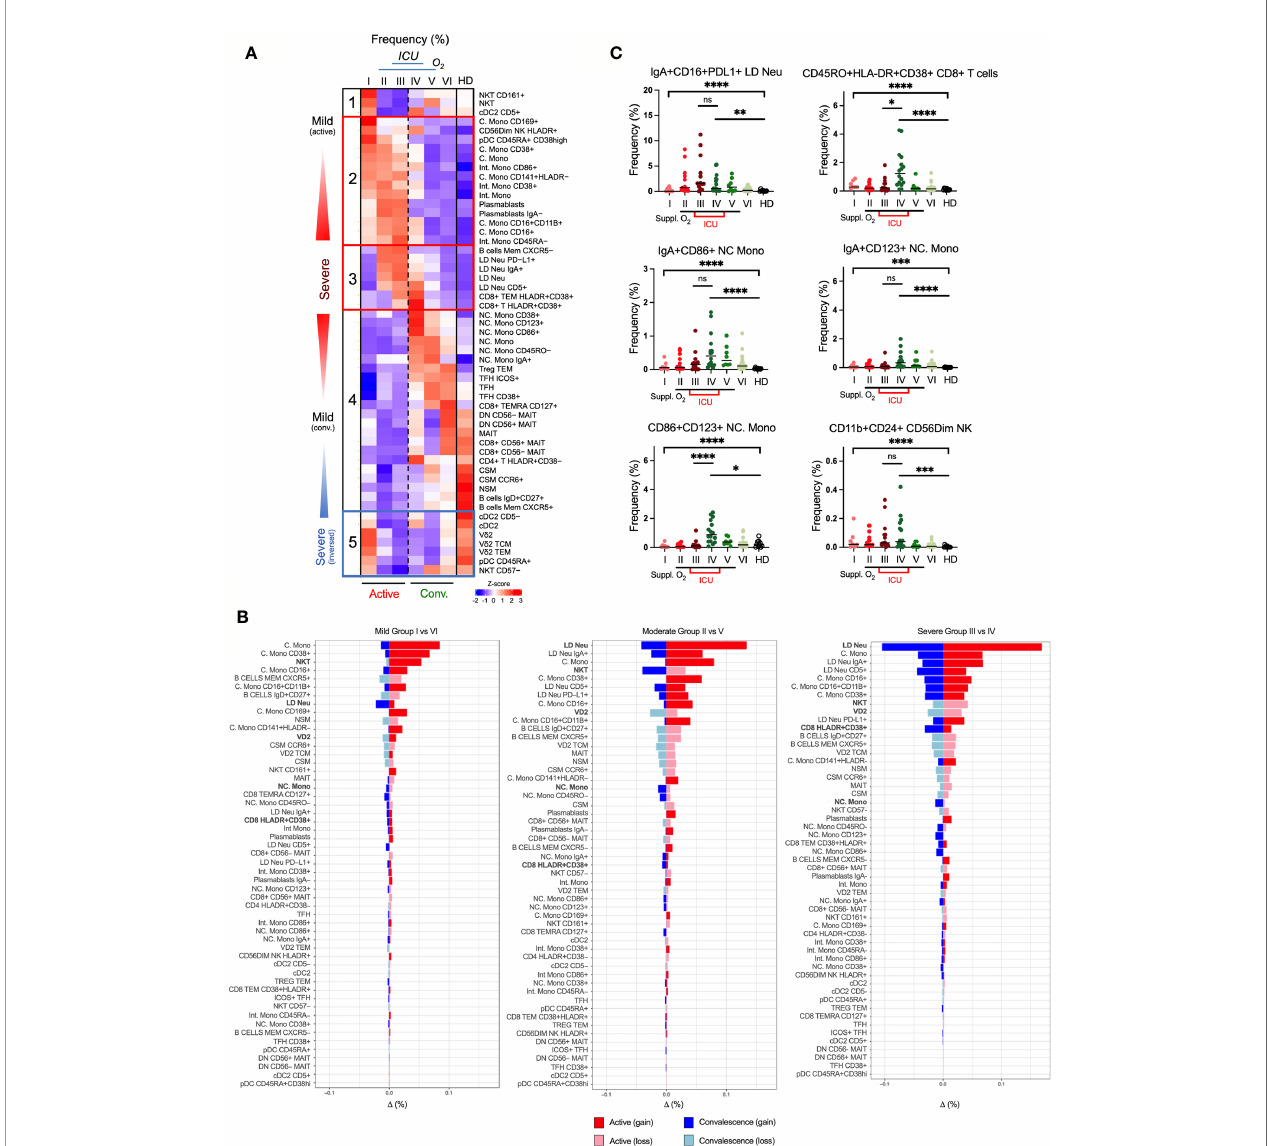
FIGURE 5 | Association of immunotypes with COVID-19 disease severity in active and convalescent individuals. (A) Left: Heatmap of CyTOF data of frequencies of 53 immune cell populations among the 6 group severity strati fi cations and divided into fi ve clusters. Right: Box-and-whiskers plots showing means and IQR increased and reduced frequency of immune cell pollutions with disease severity. (B) Enumeration of immune cell frequencies compared across severity groups against healthy donors. Selected immunotypes mentioned in this study are shown in bold. (C) Pro fi les of immunotypes persisting in convalescent severe patients. Immunotypes of LD Neu, HLA-DR + CD38 + CD8 + T cells, CD86 + /CD123 + NC. Mono and C56 Dim NK cells, are further de fi ned by co-expression of PD-L1, IgA, CD11b, CD16, CD24 or CD45RO frequencies. Scatter plots depict the means with SEM. ns, not signi fi cant, *p < 0.03; **p < 0.002; ***p < 0.0002, ****p < 0.0001 (Kruskal-Wallis test with multiple comparison corrected on each disease severity group versus total healthy). See Supplementary Figure 7 for comparisons with V d 2 T and NKT